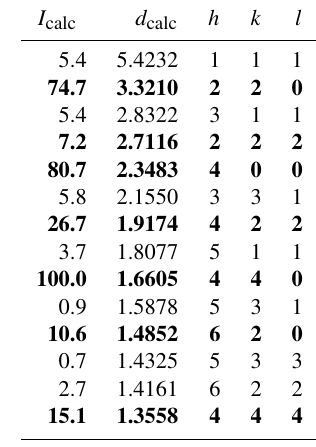
Intensity and d hkl were calculated using the software PowderCell 2.3 (Kraus and Nolze, 1996) on the basis of the structural data given in Tables 5 and 6. Only reflections with I rel . ≥ 0 .7 are listed. The seven strongest reflections are given